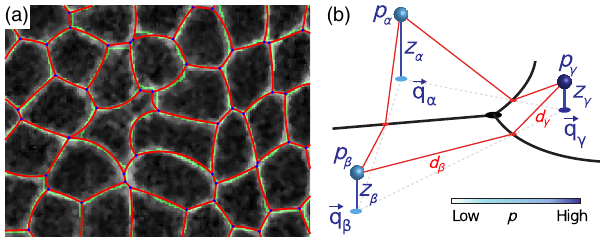
FIG. 2. Determination of equilibrium CAP tilings. (a) Fitting an equilibrium CAP tiling to imaging data. The best fit to raw data (shown in gray scale) by an equilibrium CAP tiling found by minimizing Eq. (5) is shown in red (with vertex positions in blue). The CAP contour is close, but distinct from the result of standard cell segmentation (see Sec. VII), here shown in green. (b) An example of vertex position r i derived from the generalized Voronoi construction — i.e., generating points q α displaced to height z α above the plane and a metric rescaling p α . Each CAP edge βγ is the locus of points with a fixed ratio of distances to a corresponding pair of generating points — e.g., in the above image. The vertex is defined by the intersection of all three arcs. Parameters of this generalized Voronoi construction (including p α ) provide a convenient set of reduced variables used in the minimization of Eq.